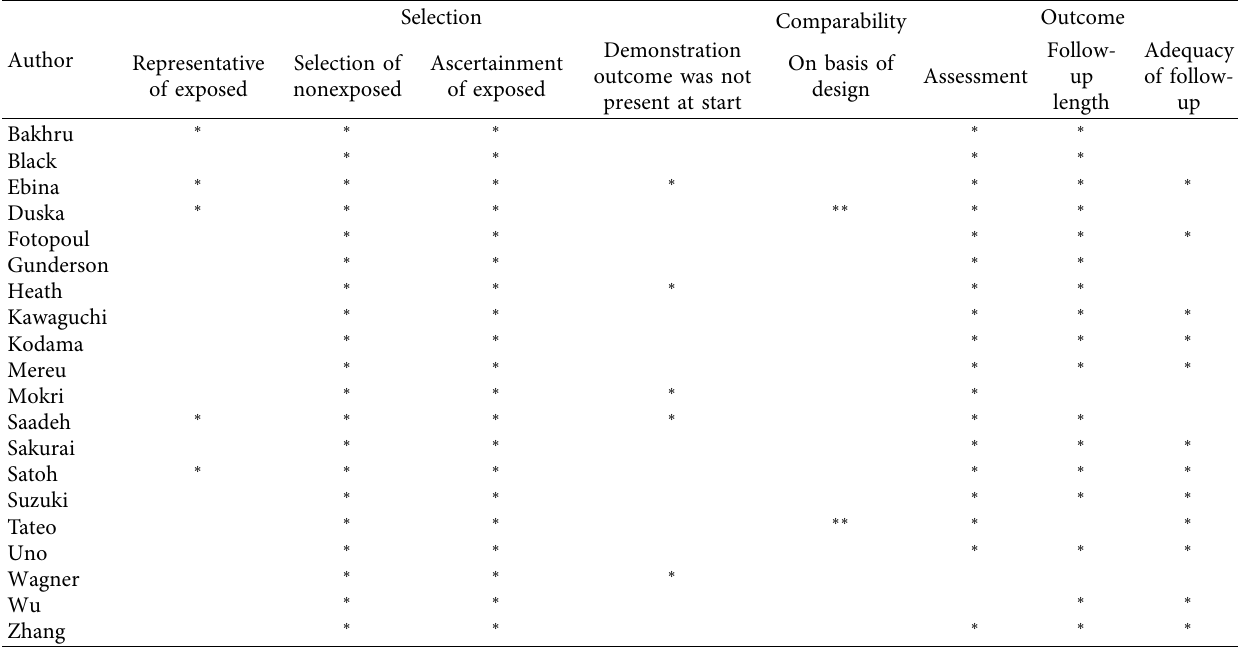
Table 2: Risk of bias assessment tool.